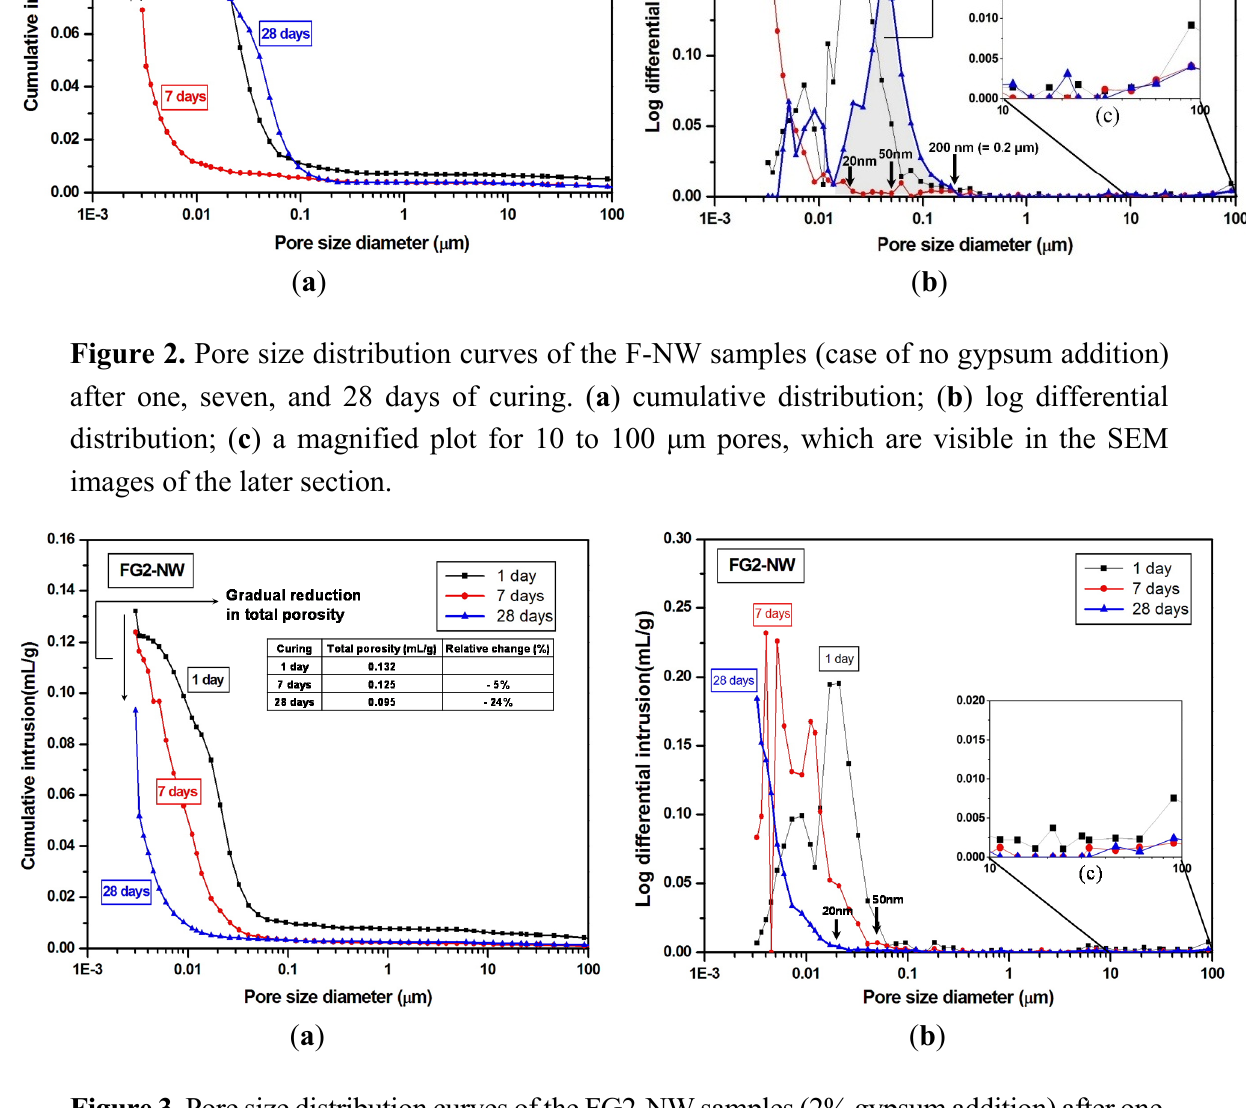
Figure 3. Pore size distribution curves of the FG2-NW samples (2% gypsum addition) after one, seven, and 28 days of curing. ( a ) cumulative distribution; ( b ) log differential distribution; ( c ) a magnified plot for 10 to 100 μ m pores, which are visible in the SEM images of the later